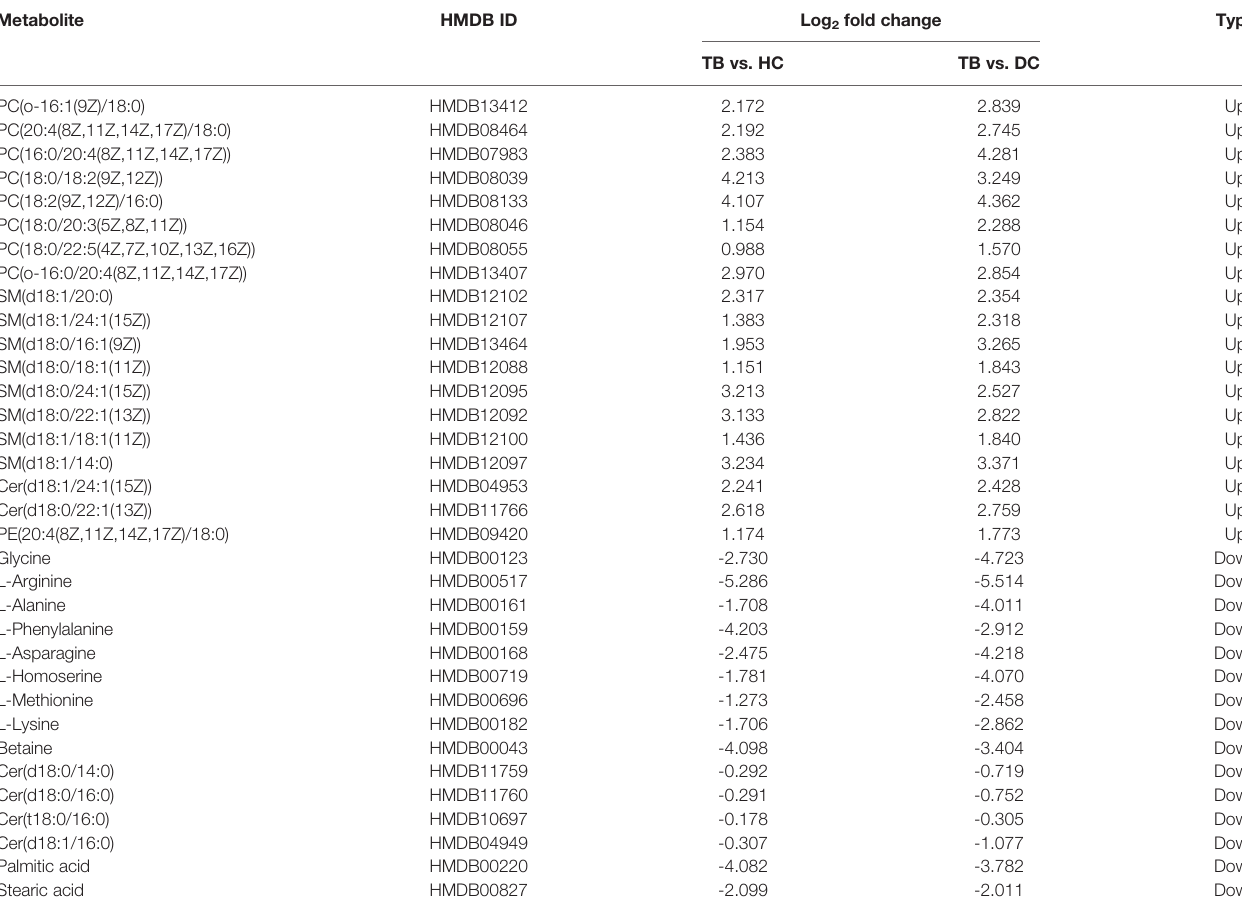
TABLE 3 | Common metabolites between TB vs. HC and TB vs. DC. Metabolite HMDB ID Log 2 fold change Type TB vs. HC TB vs.